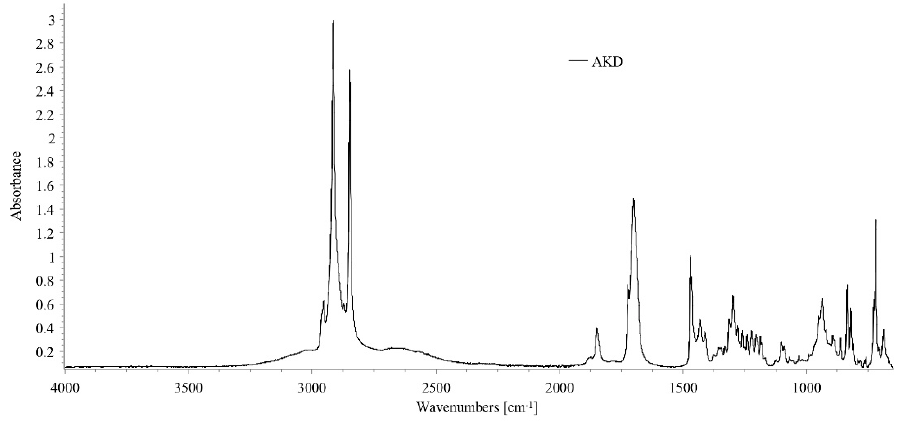
Figure 3. FTIR spectra of AKD wax [22]. Reprinted from Teresa Lovaglio (2019).